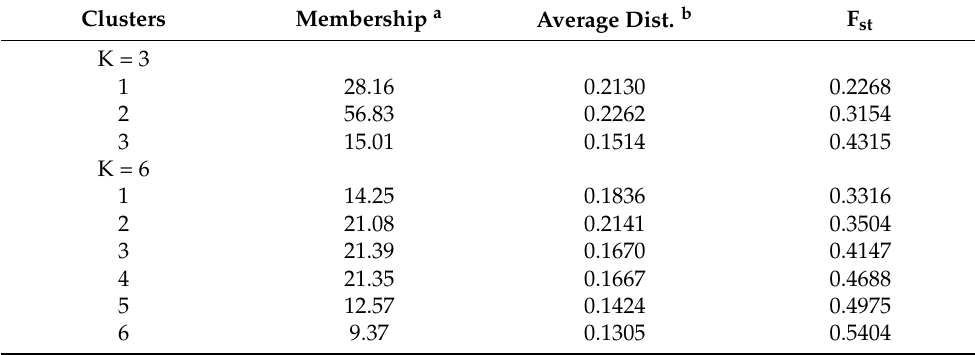
Table 5. Characteristics of STRUCTURE subpopulations.